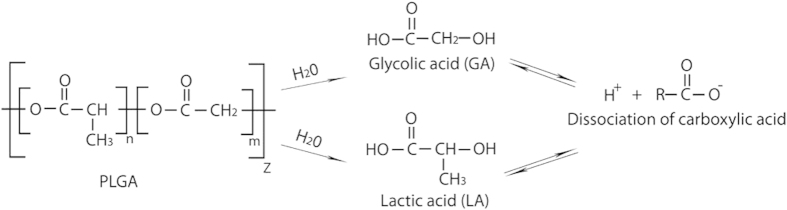
Hydrolysis reaction of the PLGA and dissociation of the carboxylic acid group.